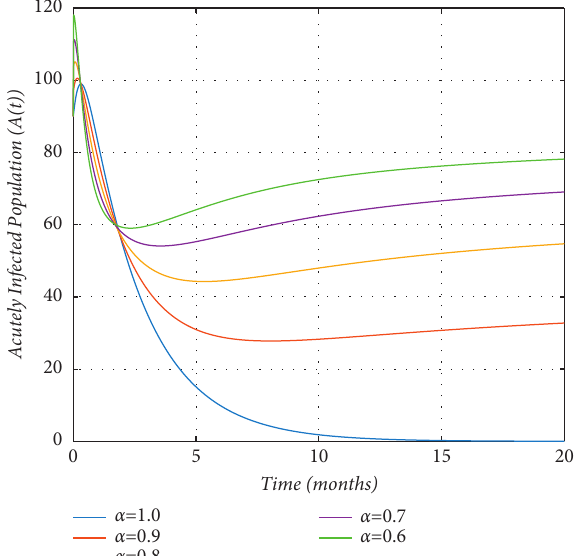
Figure 2: The graph visualizes the dynamics of the acutely infected population ( A ( t ) ) for different values of the fractional-order pa- rameter ( α ), and the initial population sizes are ( 100 , 90 , 80 , 70 , 60 ) .